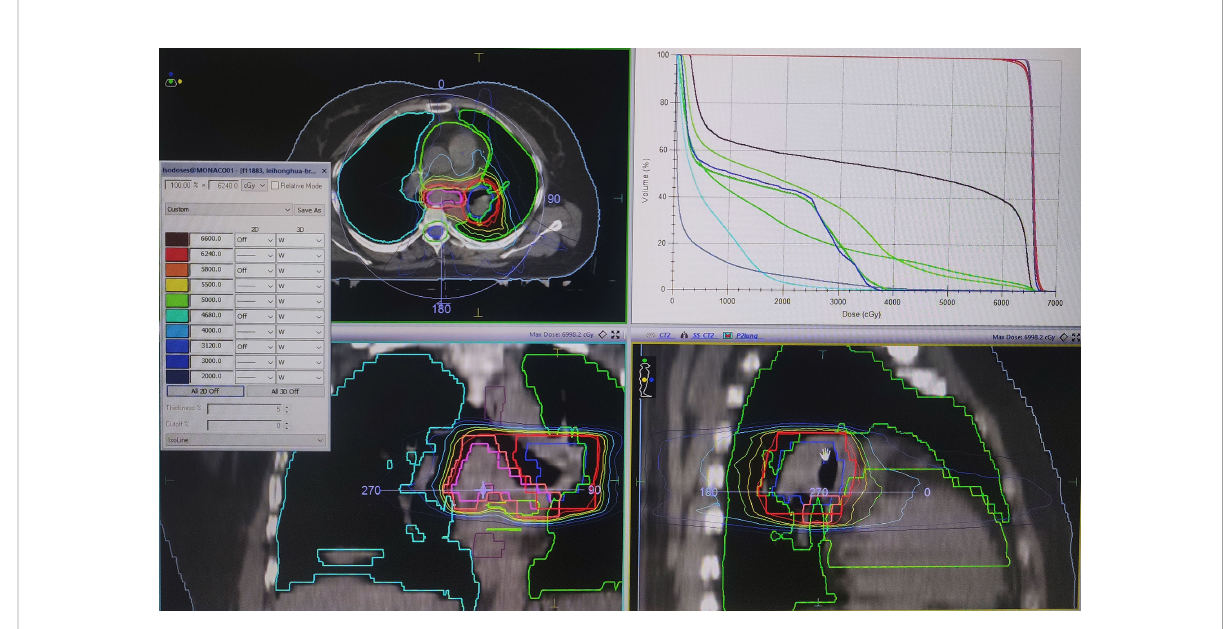
FIGURE 6 Three-dimensional dose distribution and DVH of the left porta of the lung.